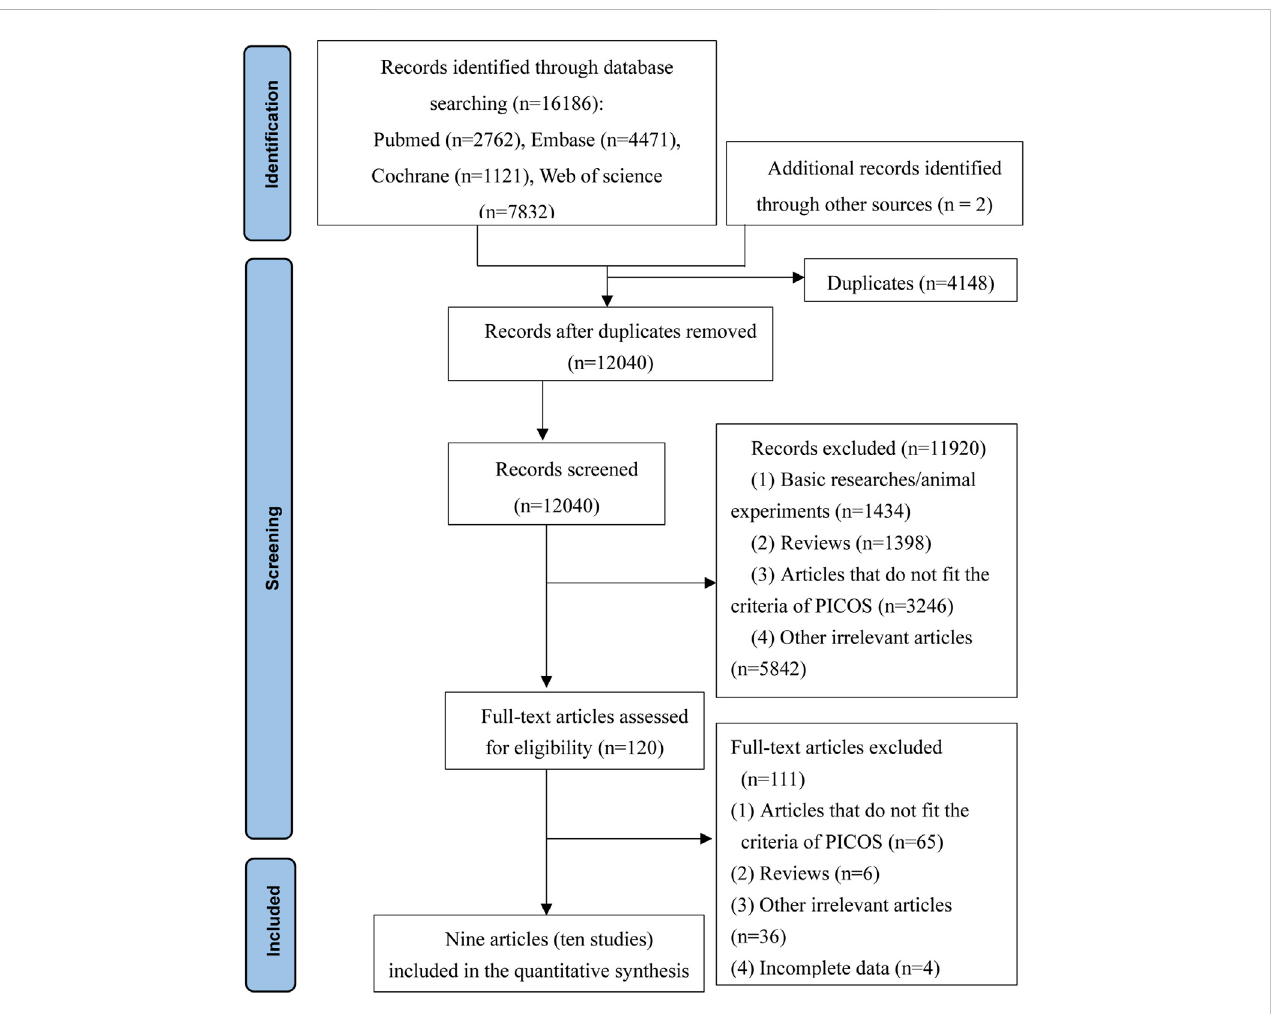
Flow chart for searching and screening of the